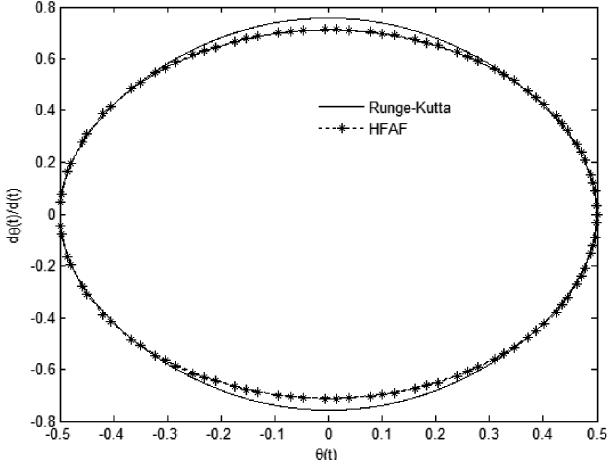
Fig. 5. Phase-plan diagram for second mode, when A = 0.5.